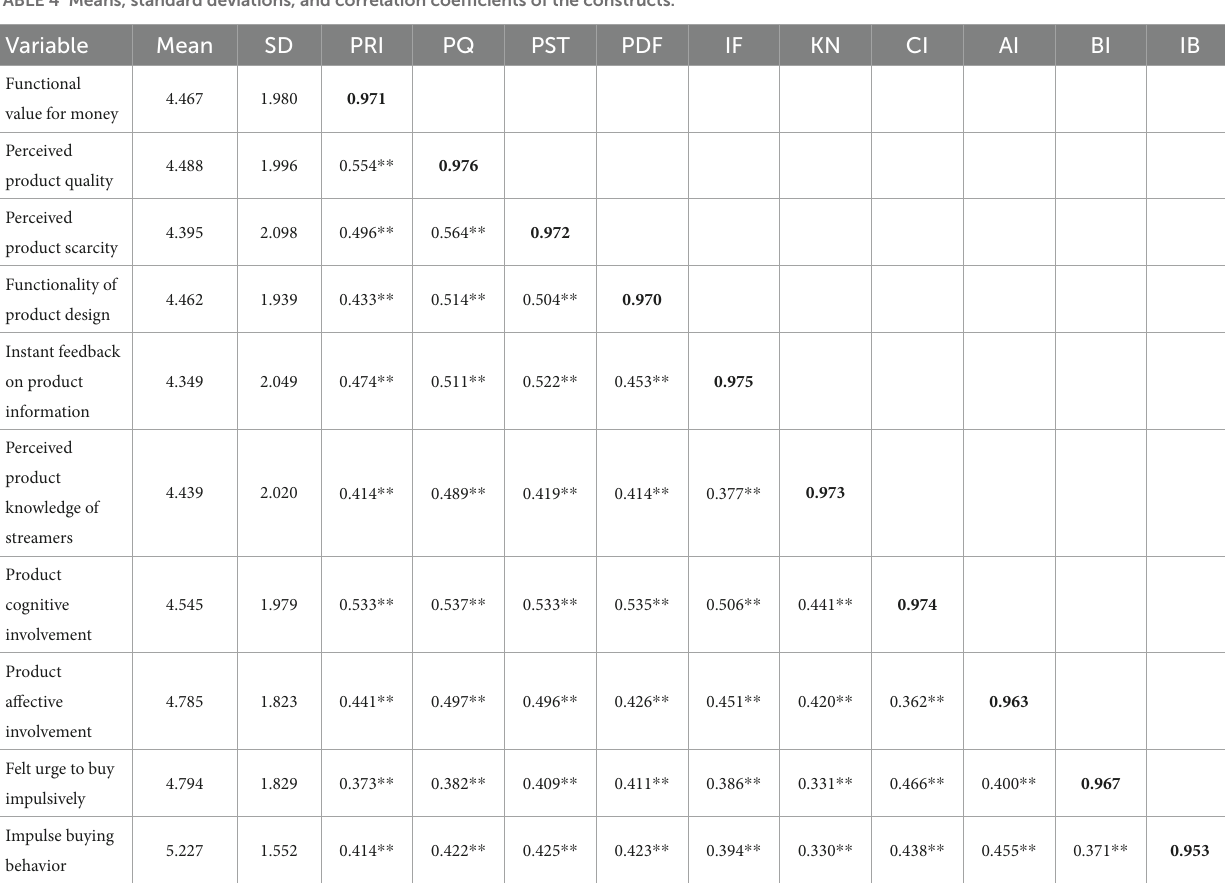
TABLE 4 Means, standard deviations, and correlation coefficients of the